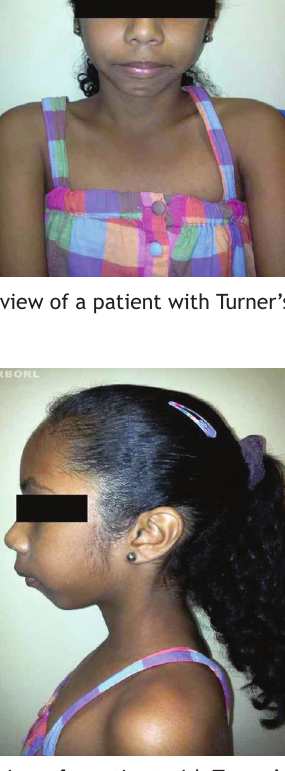
Figure 2 Lateral view of a patient with turner’s